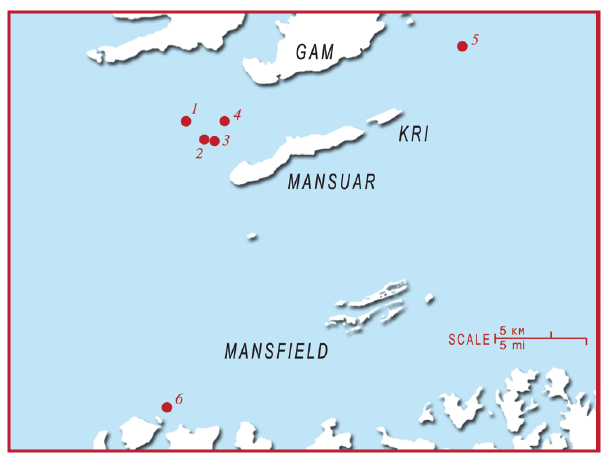
Figure 3. A map of the Raja Ampat region to indicate the location of different monitoring sites. Sites are numbered as follows: 1) Manta Sandy 2) Jetty Arborek 3) Blue Magic 4) Manta Ridge 5) Manta Heaven 6) Dayang.